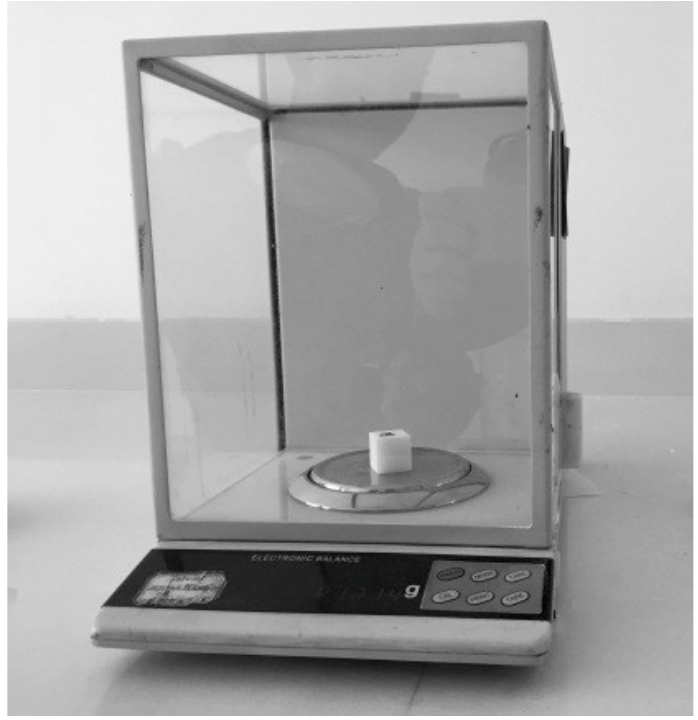
Figure 9. The size and quality parameters of sintered parts in the selection box.